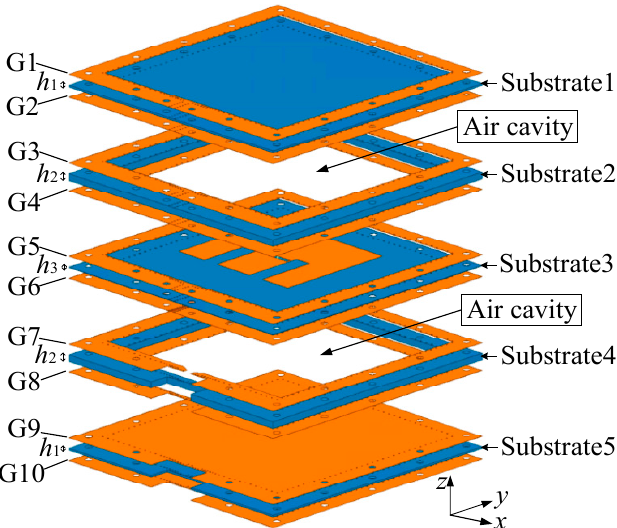
Figure 1. Layout view of the filtering antenna. Figure 2 exhibits the specific configuration and parameters of the antenna on the G6 layer, G2 layer, and G5 layer. As depicted in Figure 2a, a rectangular driven patch is placed on the G5 layer, and a pair of symmetrical longitudinal I-slot (slot1) and a transverse I- slot (slot3) are etched on the driven patch. The square stacked patch with strip groove (slot2) etched on the edge is placed on the G2 layer, as evidenced in Figure 2b. In Figure 2c, a segmented feed line is placed on the G6 layer, and the metallized via (via1) through the substrate3 connects the driven patch with the feed line.